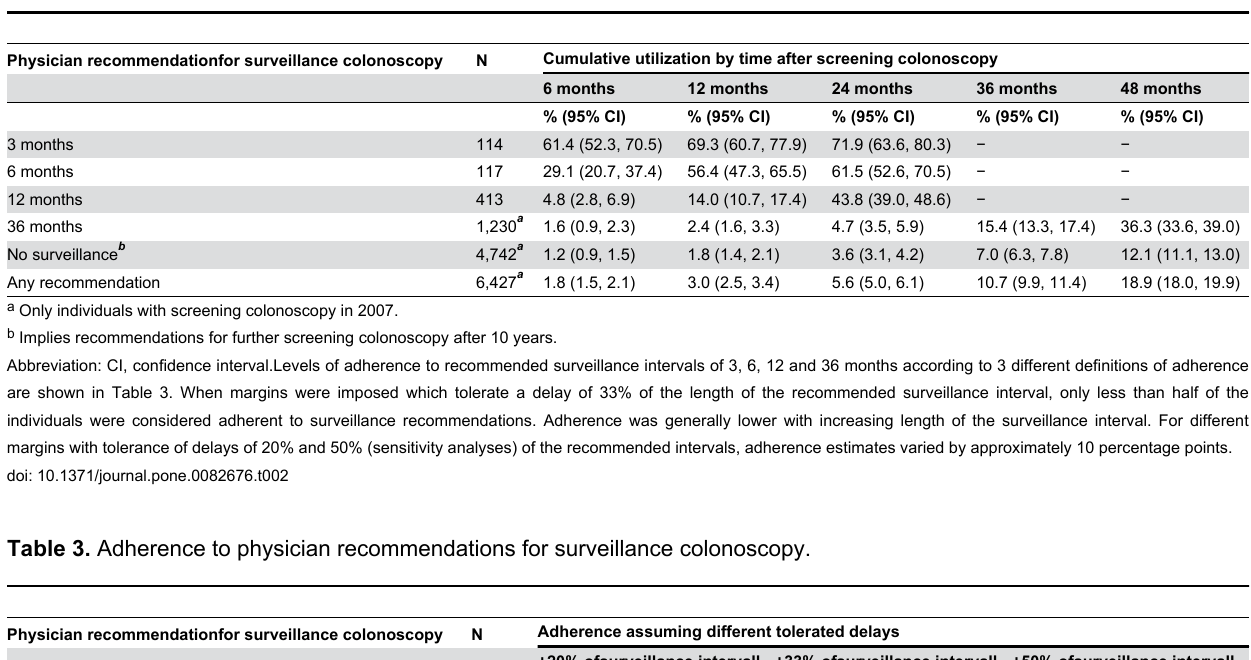
Physician recommendationfor surveillance